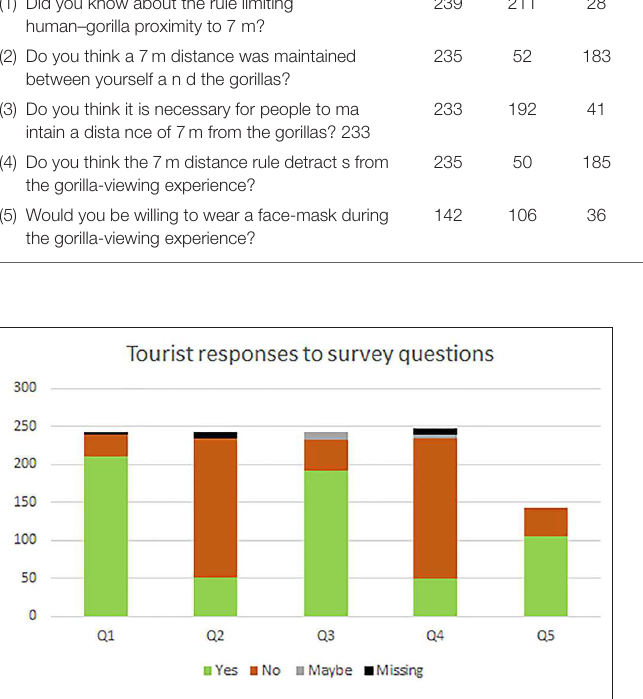
FIGURE 4 | Tourist responses to survey items on study questionnaire. (Q1) Did you know about the rule limiting human-gorilla proximity to 7 m? (Q2) Do you think a 7m distance was maintained between yourself and the gorillas? (Q3) Do you think it is necessary for people to maintain a distance of 7m from the gorillas? (Q4) Do you think the 7m distance rule detracts from the gorilla-viewing experience? (Q5) Would you be willing to wear a face-mask during the gorilla-viewing experience? (in these charts, green indicates “yes,” orange indicates “no,” gray indicates “maybe/uncertain,” and black indicates no